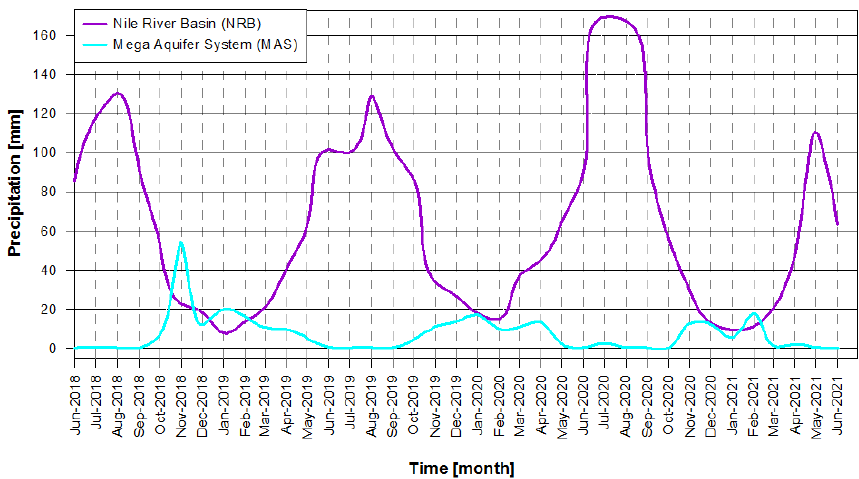
Figure 6. Average monthly precipitation in mm over the NRB and the MAS from June 2018 to June 2021.